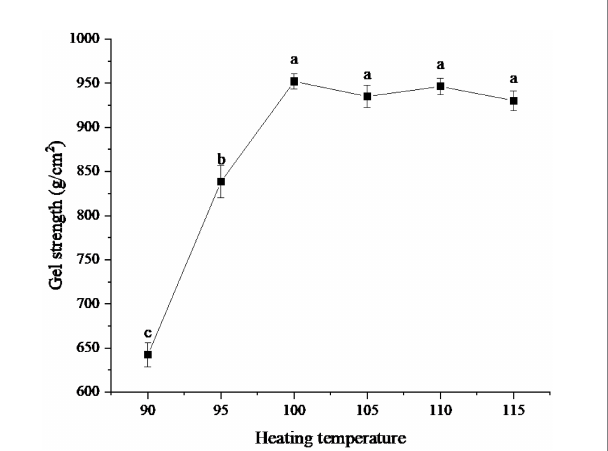
FIGURE 2 Effect of pH on gel strength of protein powder. Different lowercase letters express the significant differences ( p < 0.05).